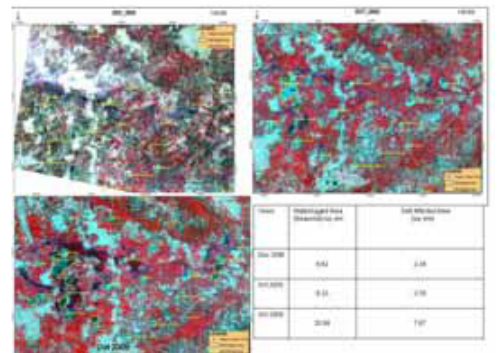
Fig. 2: DSM of Chamba watershed, HP.